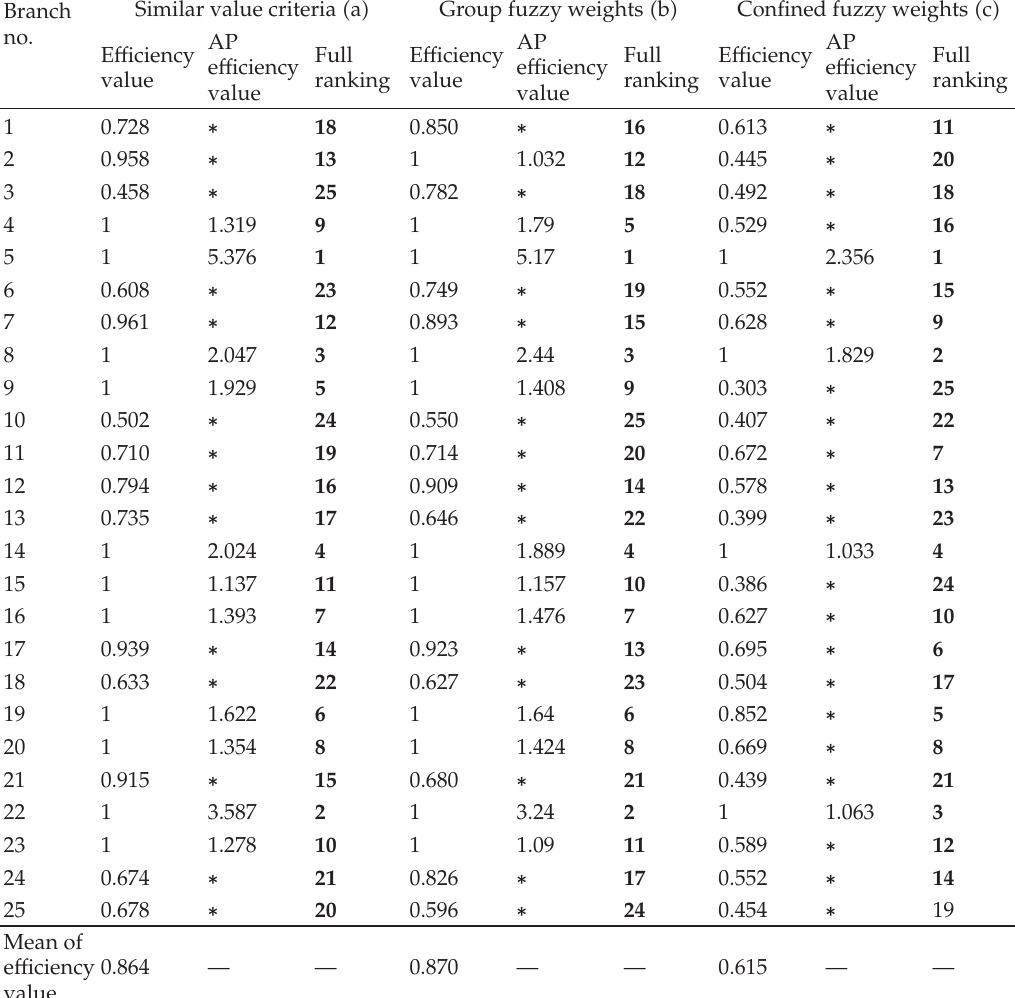
Table 7: Comparative result of e ffi ciency value through three types of CCR